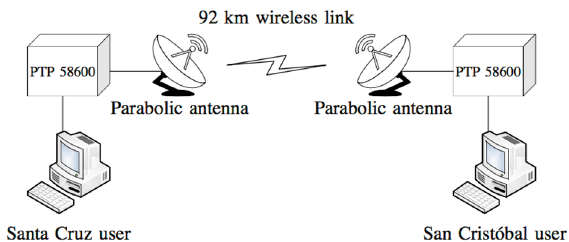
Figure 7. Long-distance network topology.